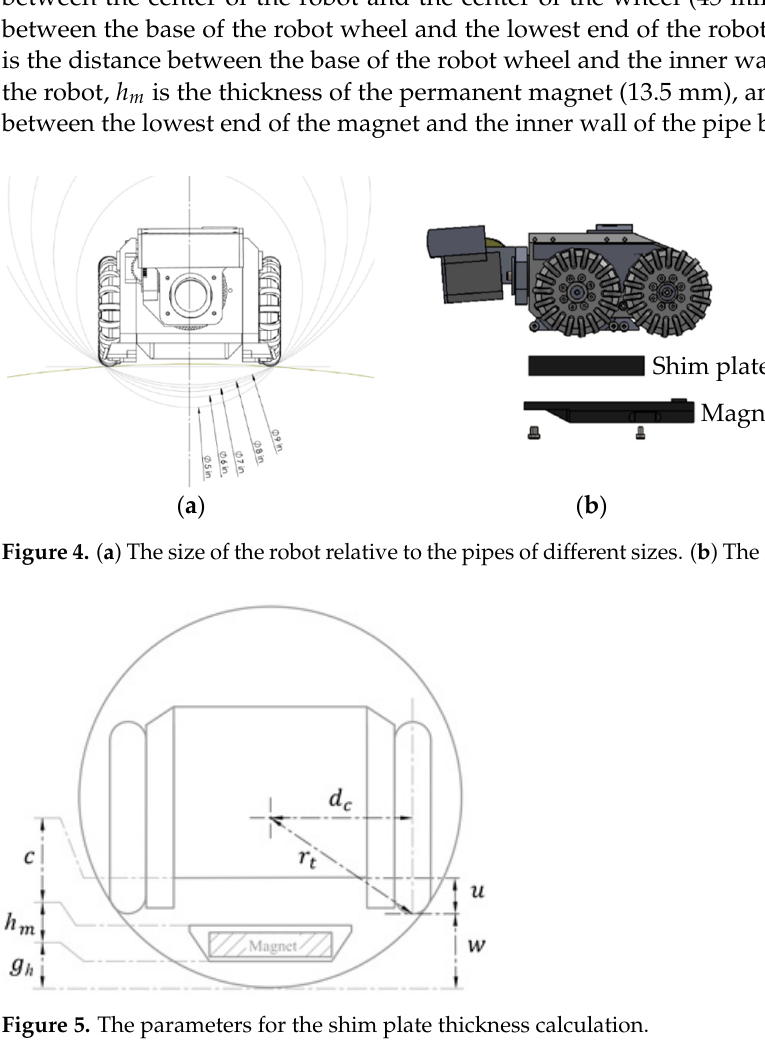
Figure 3. The 3D CAD design of the omnidirectional wheel.